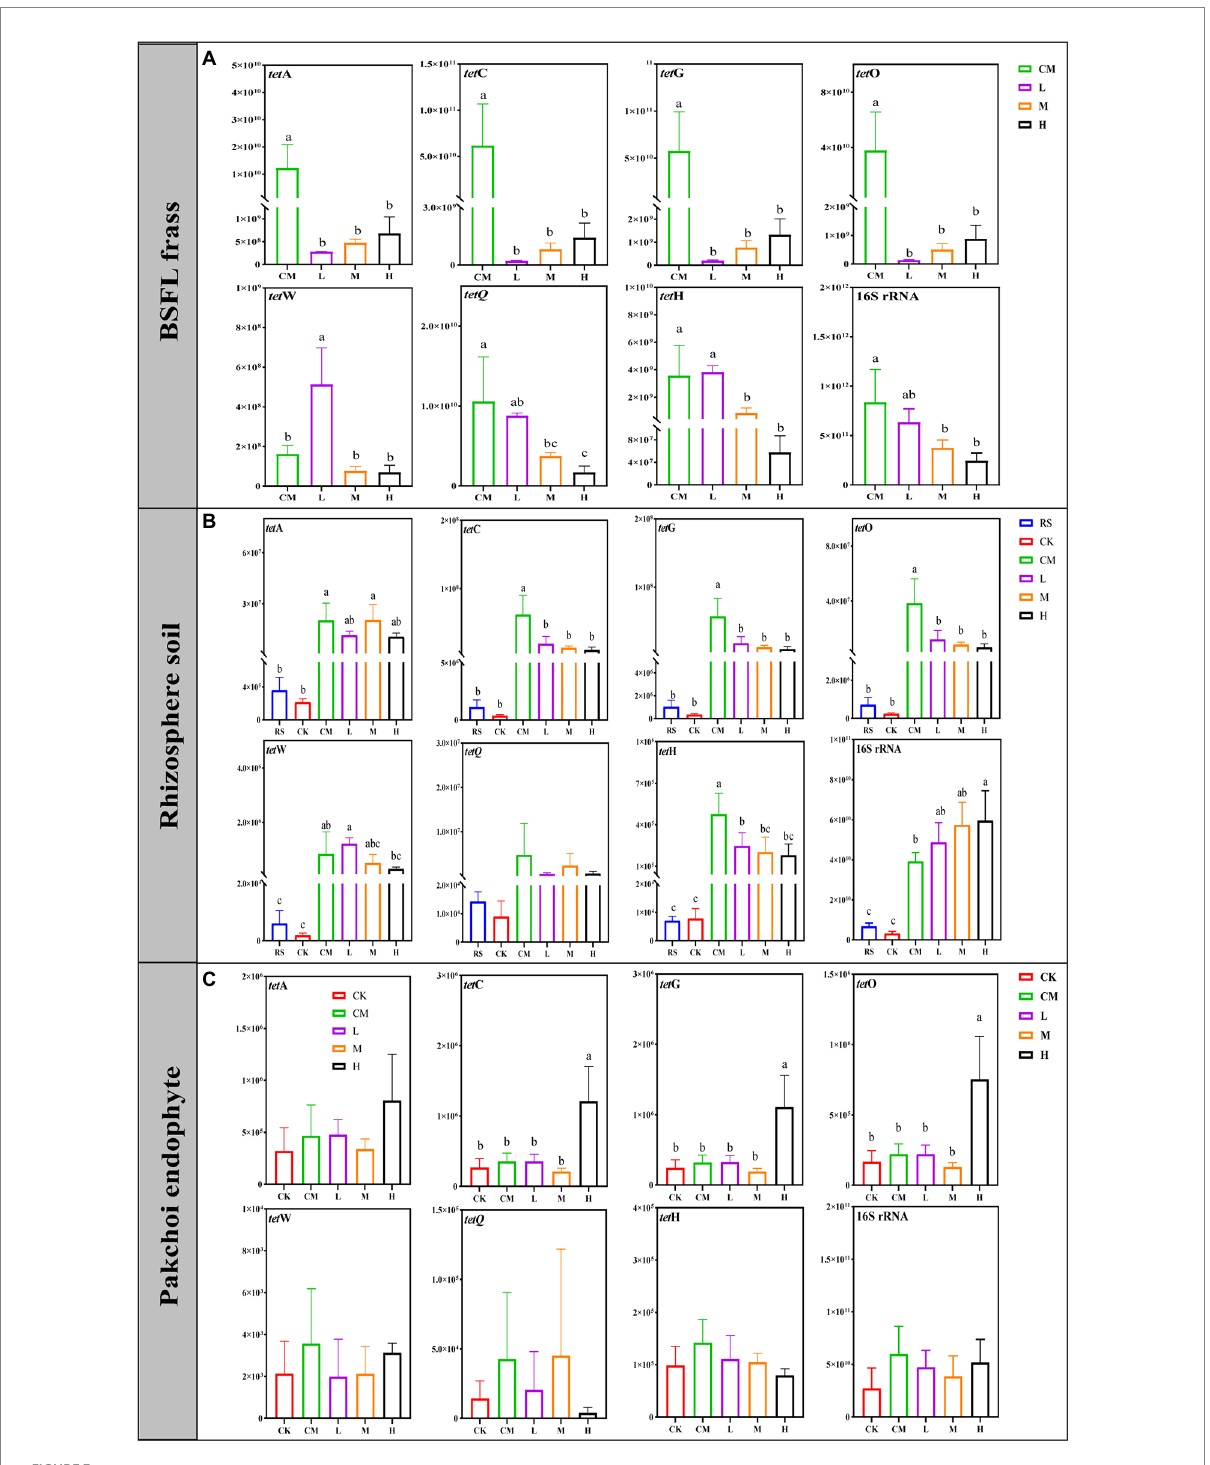
FIGURE 3 The absolute abundance of TRGs in BSFL frass (A) , rhizosphere soil (B) , and pakchoi endophytes (C) among different treatments. Significant differences between the means were determined by Tukey’s test. Differences were considered significant when p < 0.05, and different lowercase letters indicate significant differences. “RS” means initial pure soil, “CK” means untreated soil, “CM” means untreated manure without BSFL, “L” means 50 BSFL cultured in 100 g of fresh manure, “M” means 100 BSFL cultured in 100 g of fresh manure, “H” means 1,000 BSFL cultured in 100 g of fresh